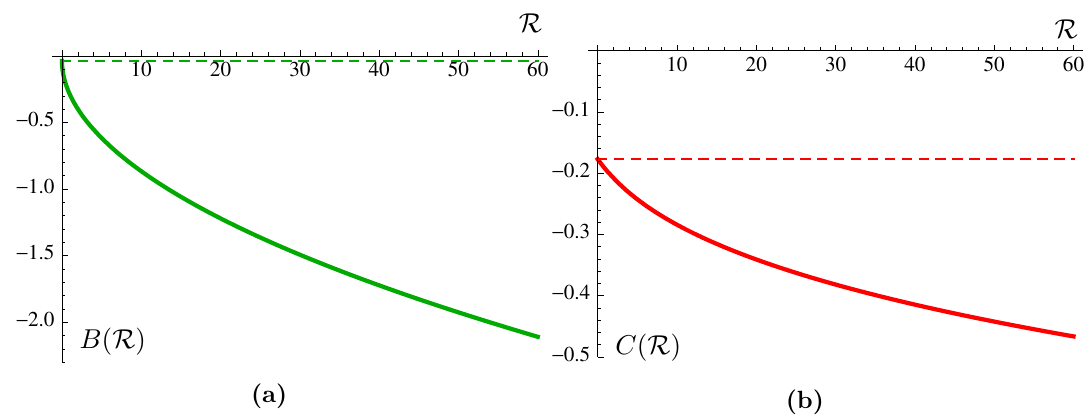
Figure 5. B vs. R (a) and C vs. R (b) for RG (cid:13)ow solutions in the potential (2.45) d = 3, (cid:1) (cid:0) = 1 : 2 and (cid:21) chosen such that ’ min = 1. For R ! 0 both B ( R ) and C ( R ) attain a (cid:12)nite value indicated by the green and red dashed line,